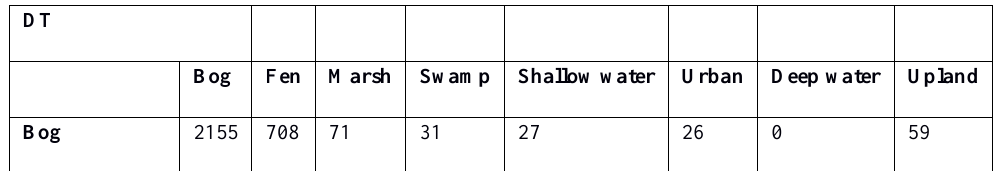
editor are shown in Figure 3 and Table 4. While the XGB classifier had better performance over the RF and DT classifier, its computation in the GEE was slow, and we needed to use a bigger scale parameter to avoid the error of the high computation cost.